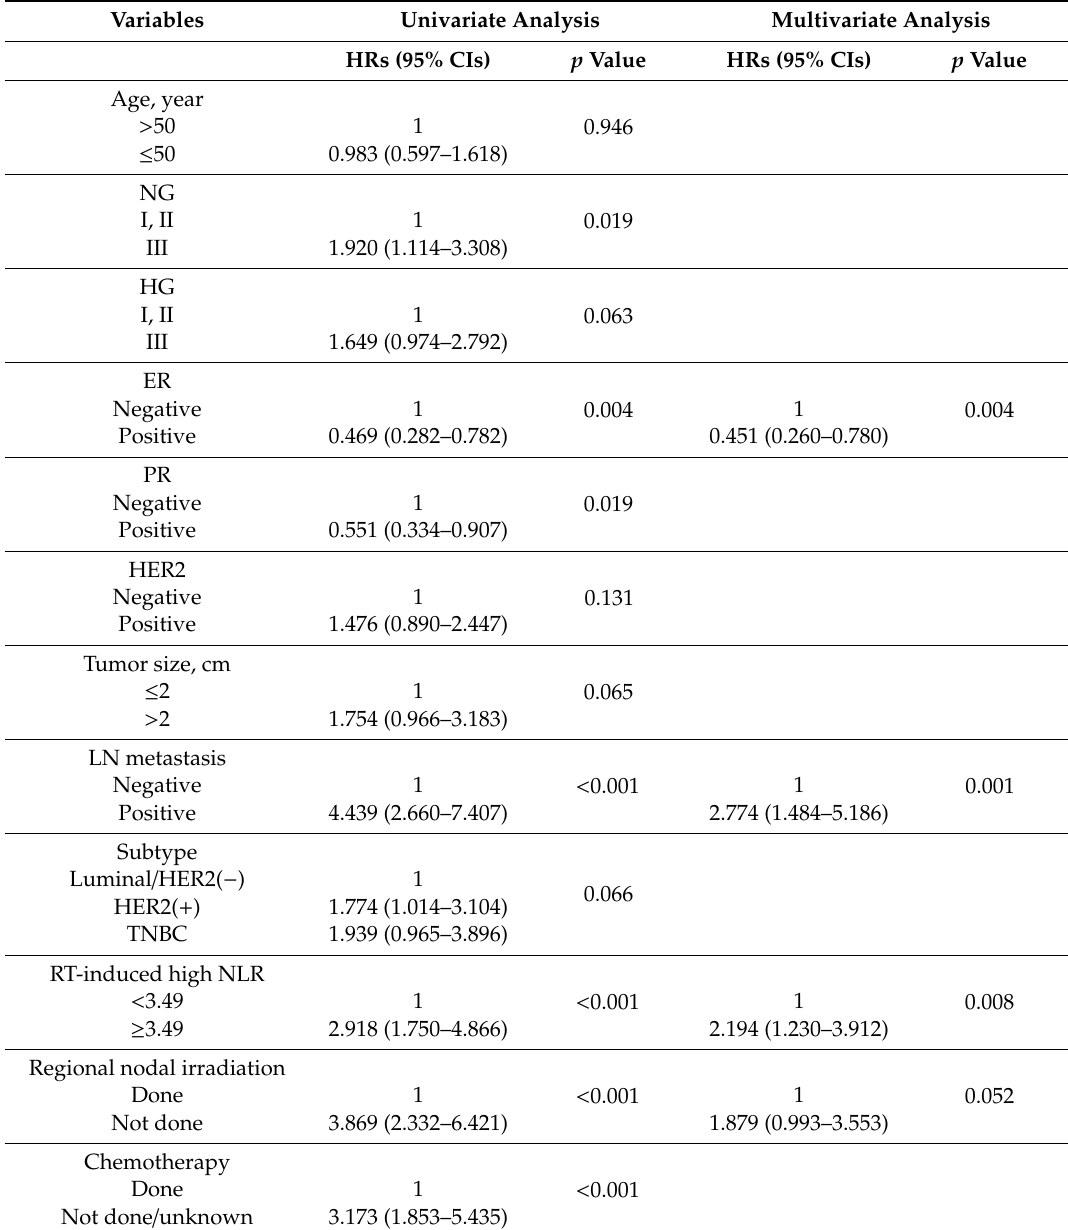
Abbreviations: NG, nuclear grade; HG, histologic grade; ER, estrogen receptor; PR, progesterone receptor; HER-2, human epidermal growth factor receptor-2; LN, lymph node; TNBC, triple negative breast cancer; RT, radiotherapy; NLR, neutrophil to lymphocyte